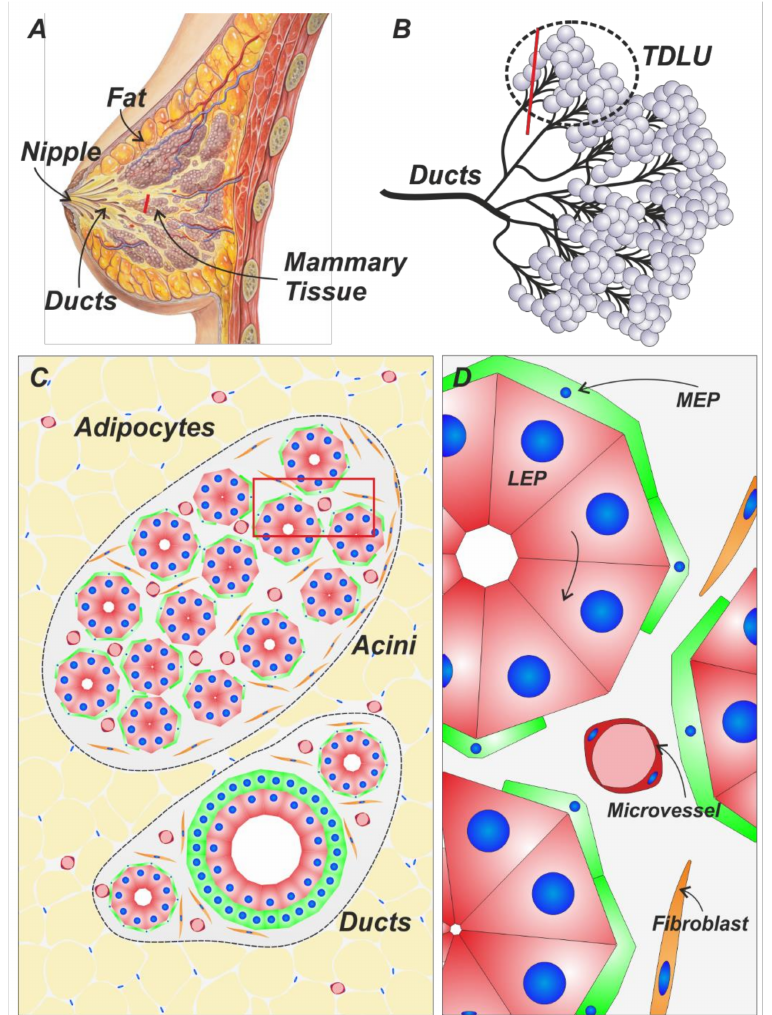
Figure 1. ( A ) The breast gland is composed of branching epithelial ducts that are embedded in collagen and fat-rich stroma. ( B ) These ducts terminate in the TDLU, the functional, milk-producing unit of the breast gland. Artwork in panel A is adapted from Patrick J. Lynch (CC BY 3.0). Red line depicts a virtual cut shown in panel C. ( C ) The TDLU is composed of acini and small ducts, joining together into larger ducts. The mammary tissue is embedded in a collagen-rich stroma, further embedded in a fatty connective tissue. The red box delineates the area magnified in panel D. ( D ) Mammary acini and ducts are arranged in double-layered structures. LEPs are situated towards the lumen, MEPs line the outside. Different cellular components within the breast gland can be characterized using identifying